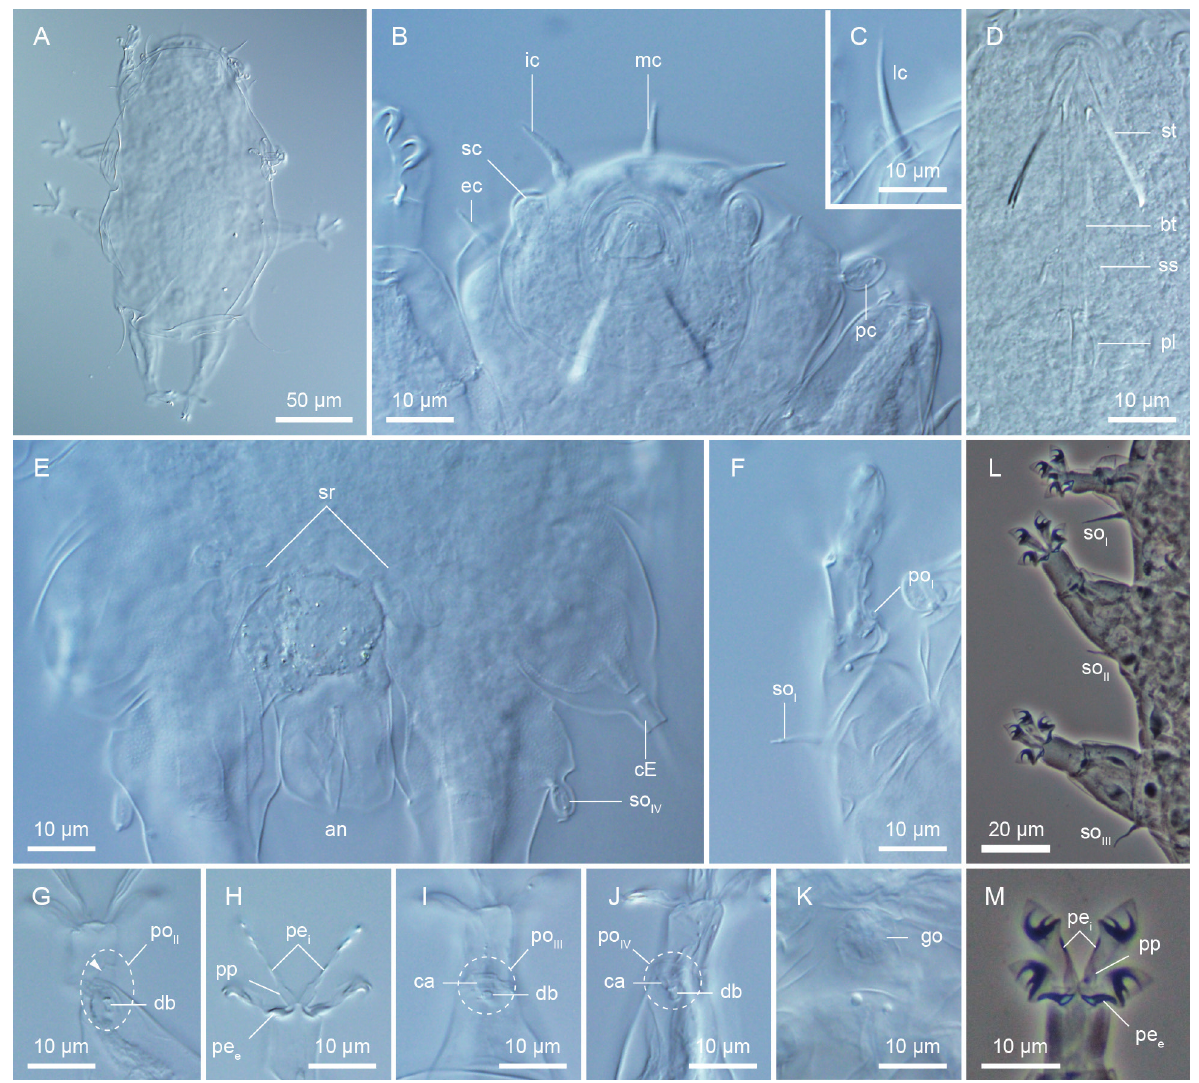
Figure 2. DIC and PhC micrographs of Cyaegharctus kitamurai gen. et sp. nov., adult female. A. Habitus (dorsal view). B. cephalic region (ventral view). C. Lateral cirrus. D. Buccal apparatus. E. Caudal region (ventral view) (epicuticle pillars visible). F. Leg I sensory organ and pocket organ. G. Leg II pocket organ (arrowhead indicates protruding portion). H. Leg II digits and claws. I.